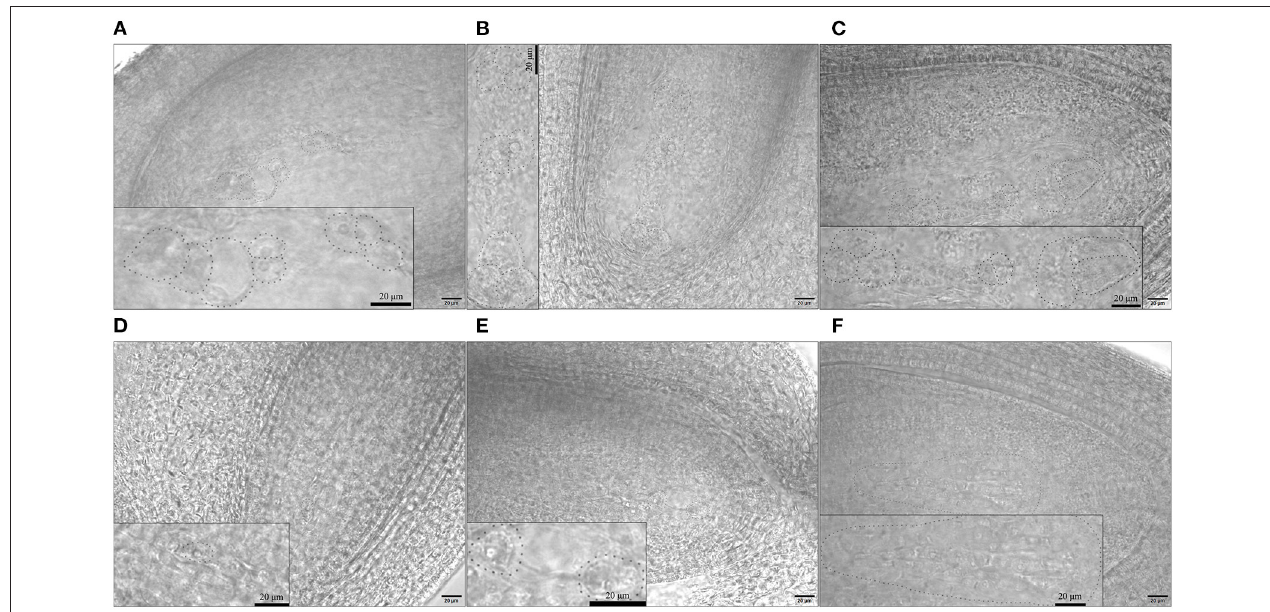
FIGURE 7 | Images of normal and abnormal embryo sacs: (A–C) normal embryo sacs of H30-6, H411, and B336, respectively. (D–F) abnormal embryo sacs of H30-6: (D) embryo sac at the tetrad stage, (E) embryo sac at the binucleate embryo sac stage, (F) without embryo sac. The embryo sac area was magnified in the small box on each image. Scale: 20 µ m.